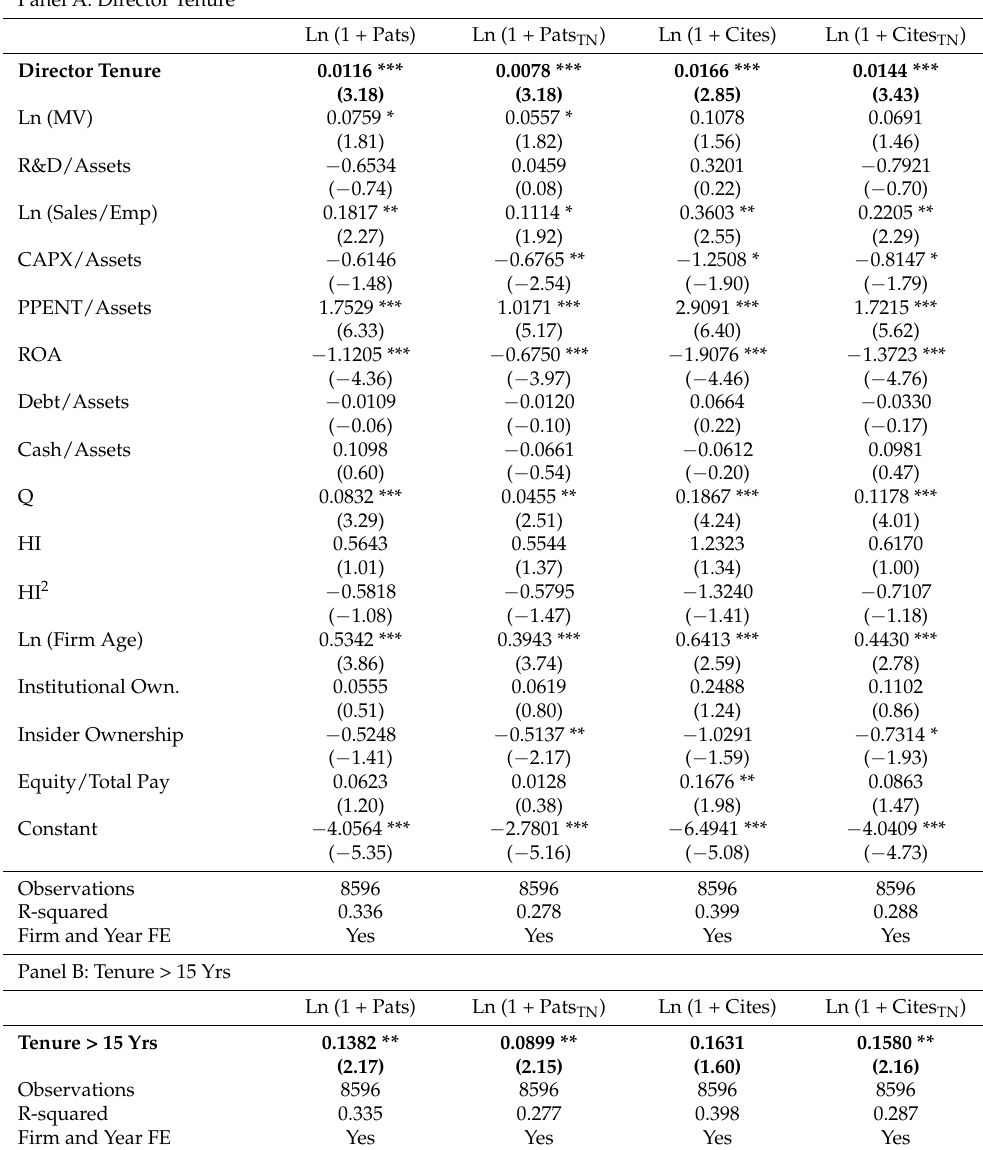
Table 6. Regressions of Innovation on Director Entrenchment. This table presents regression results of Innovation on various measures of Director Entrenchment. Panel A examines Director Tenure, defined as the average tenure, on the board, of directors; Panel B examines Tenure >15 Yrs, defined as the percentage of directors with a tenure on the board of 15 years or more; Panel C examines Tenure < 5 Yrs, defined as the percentage of directors with a tenure on the board of less than 5 years; Panel D examines BCF E-Index, defined as the sum of six anti-takeover provisions as in Bebchuk et al. (2009); Panel E examines GIM G-Index, defined as the anti-takeover index from Gompers et al. (2003); and Panel F examines CEO-Chair Duality, an indicator variable that equals one if the firm has a dual CEO-Chair position, zero otherwise. Control variables are omitted for brevity in Panels B, C, D, E and F. All regressions contain firm and year fixed effects. All except binary variables are winsorized at the upper and lower 1% levels. Full variable definitions are provided in the Appendix A. T-statistics are reported in parentheses. Standard errors are adjusted based on the Huber-White sandwich estimate of variances and are clustered by firm. *** indicates significance at the 1% level, ** 5% and * 10%. Panel A: Director